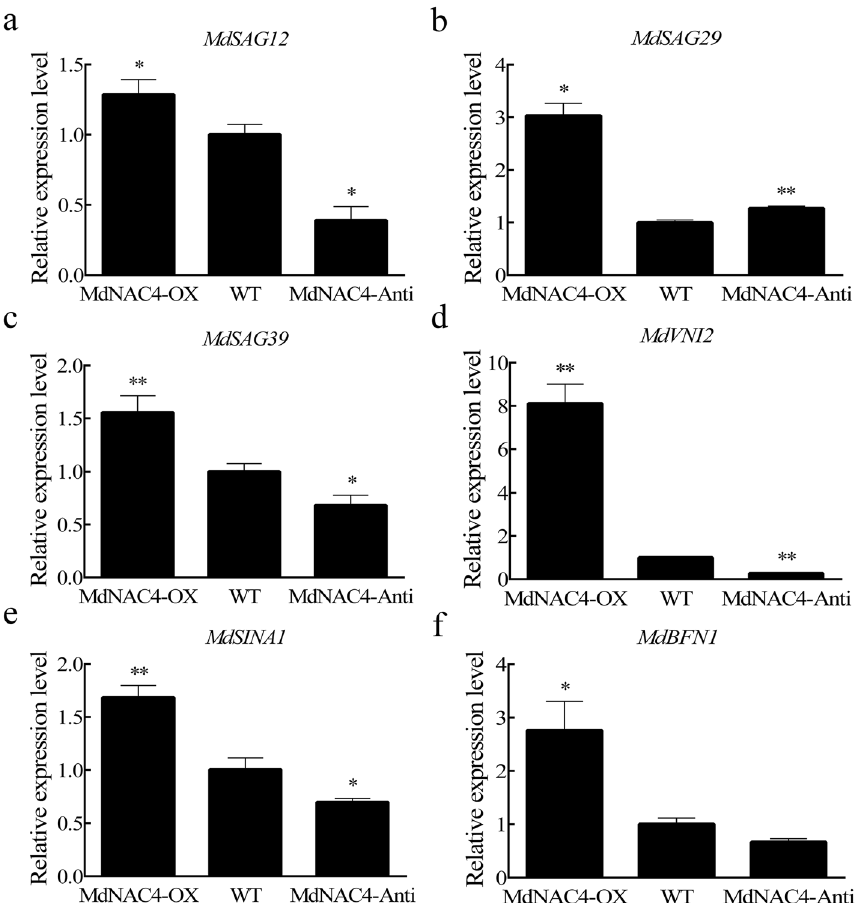
Fig. 5 Expression levels of senescence-related genes ( a‑f MdSAG12 , MdSAG29 , MdSAG39 , MdVNI2 , MdSINA1 , and MdBFN1 ) in 2-week-old apple calli. WT: wild-type; MdNAC4-OX: with MdNAC4 overexpression vector; MdNAC4-Anti: with MdNAC4 antisense vector. The WT expression level was set at 1. Error bars indicate the SDs of the three technical replicates and three biological replicates. Asterisks indicate significant differences between two independent samples according to t tests (*, P < 0.05 and **, P < 0.01)